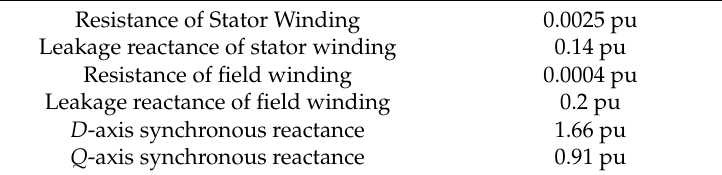
Table 3. Electrical parameters of the fixed speed synchronous generator (FS-SG).